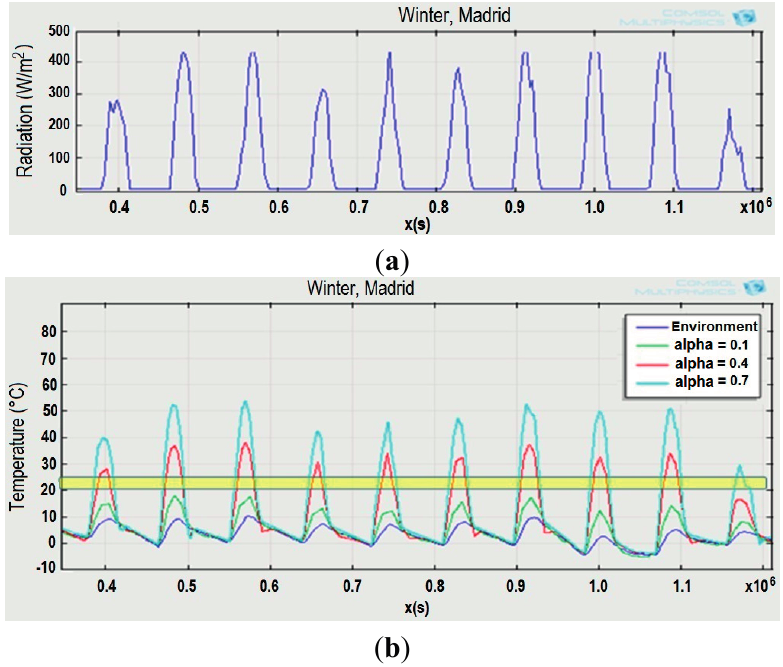
Figure 3. ( a ) Solar radiation in Madrid (Spain) in winter (10 days); ( b ) Temperature for different roof solar collector alpha